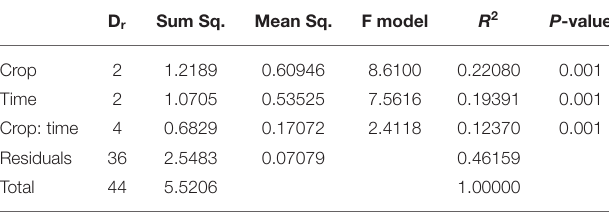
TABLE 2 | perMANOVA for the factors crop and sampling time. D r Sum Sq. Mean